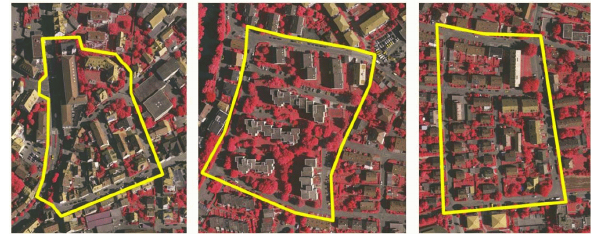
Figure 1. Test sites of scene Vaihingen. ’Inner City’ (Area 1, left), ’High-Riser’ (Area 2, middle) and ’Residential’ (Area 3, right) (Rottensteiner et al.,